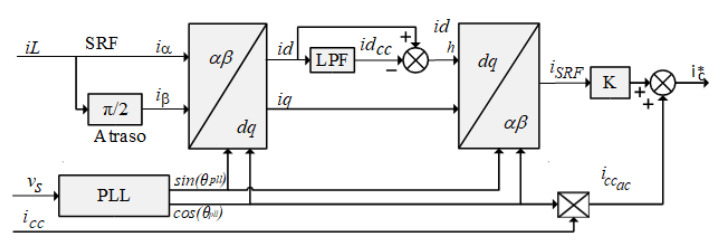
Figure 7. Synchronous Reference Frame method.